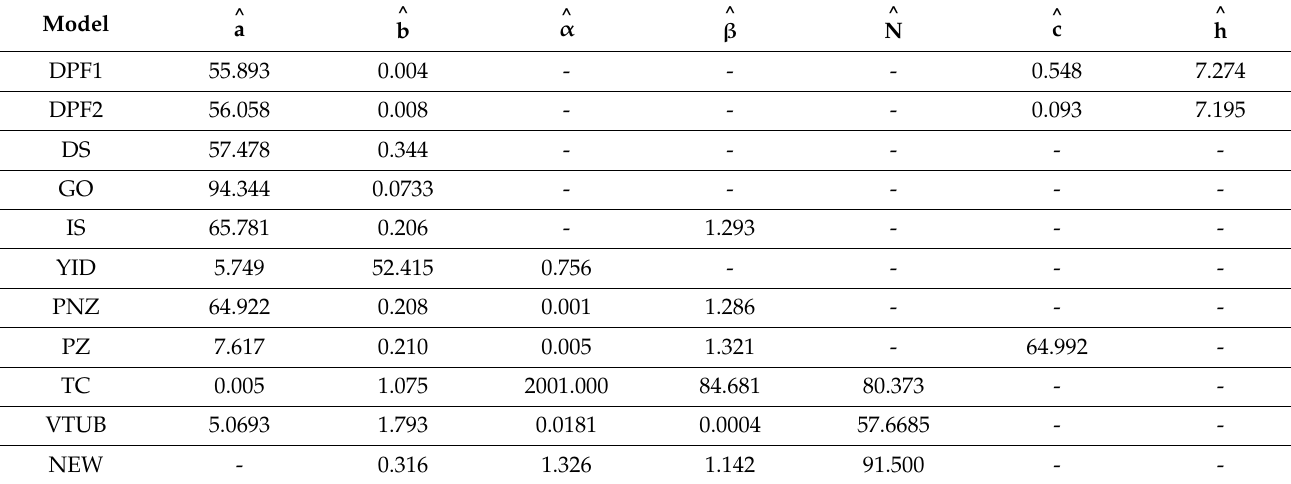
Table 6. Estimated parameters of models for dataset 2.